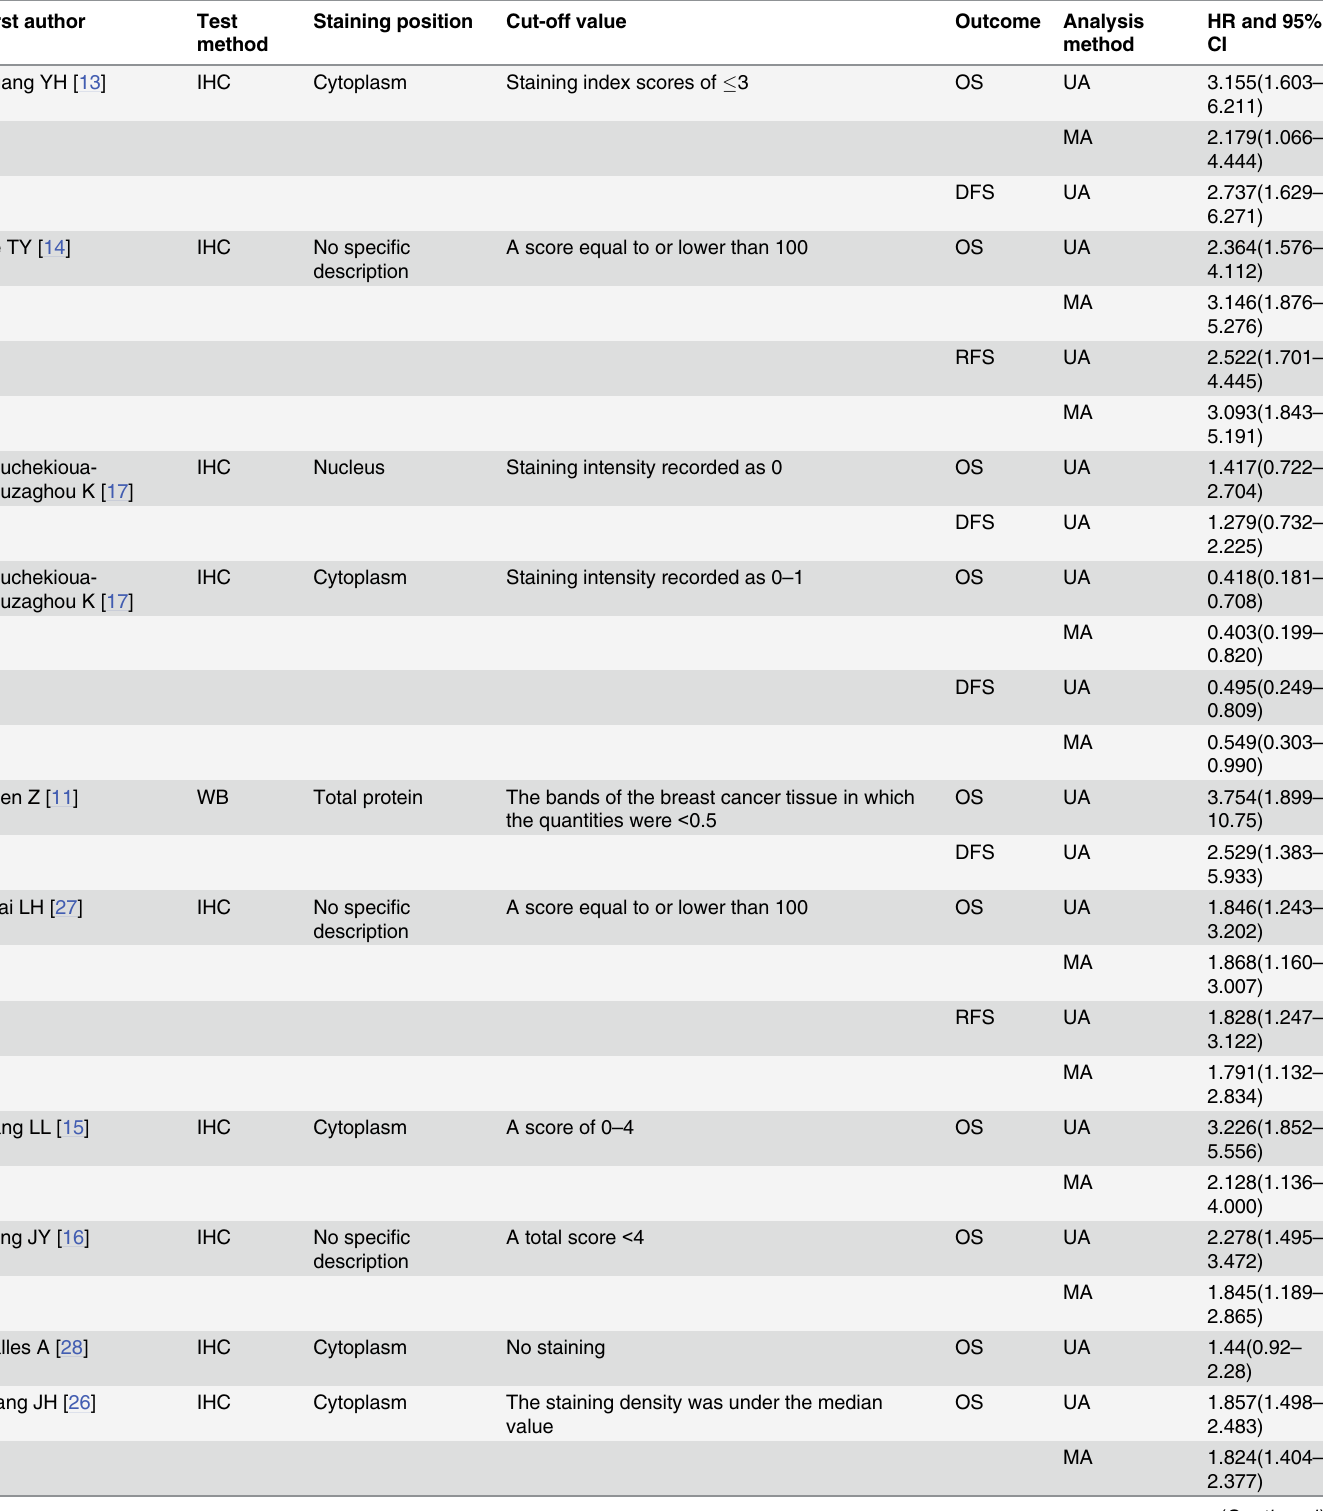
Table 2. LKB1 evaluation and survival data of the selected